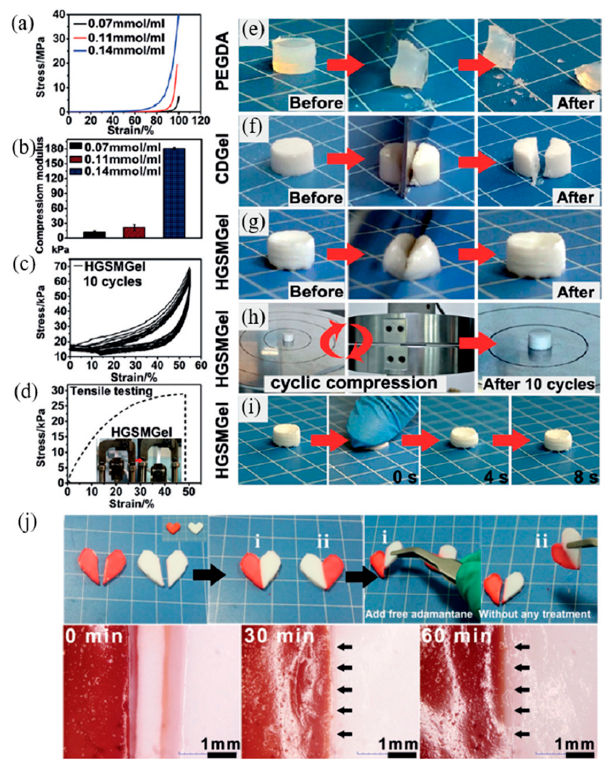
Figure 23. The mechanical properties of HGMS hydrogel in terms of ( a ) compression curves of hydrogel with various HGSM contents, ( b ) compression modulus of hydrogel with various HGMS contents, ( c ) cyclic compression test curves, and ( d ) stress–strain curve of HGSM hydrogel. The self-healing process of host–guest supramolecular hydrogels; ( e – g ) photographs of conventional hydrogel compared to HGSM hydrogel, ( h , i ) shape recovery of hydrogel after cyclic compression and compression by squashed, and ( j ) healing process and micrographs of healed samples [114]. Adapted from [114], with permission from John Wiley and Sons.